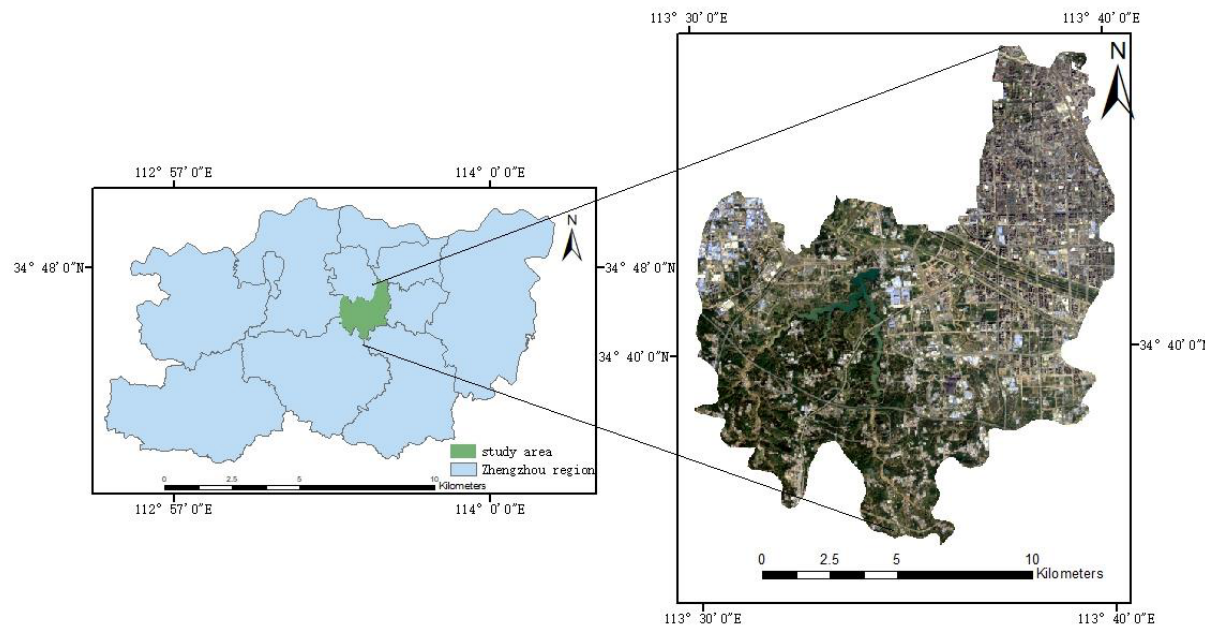
Figure 1. Location of the study area.